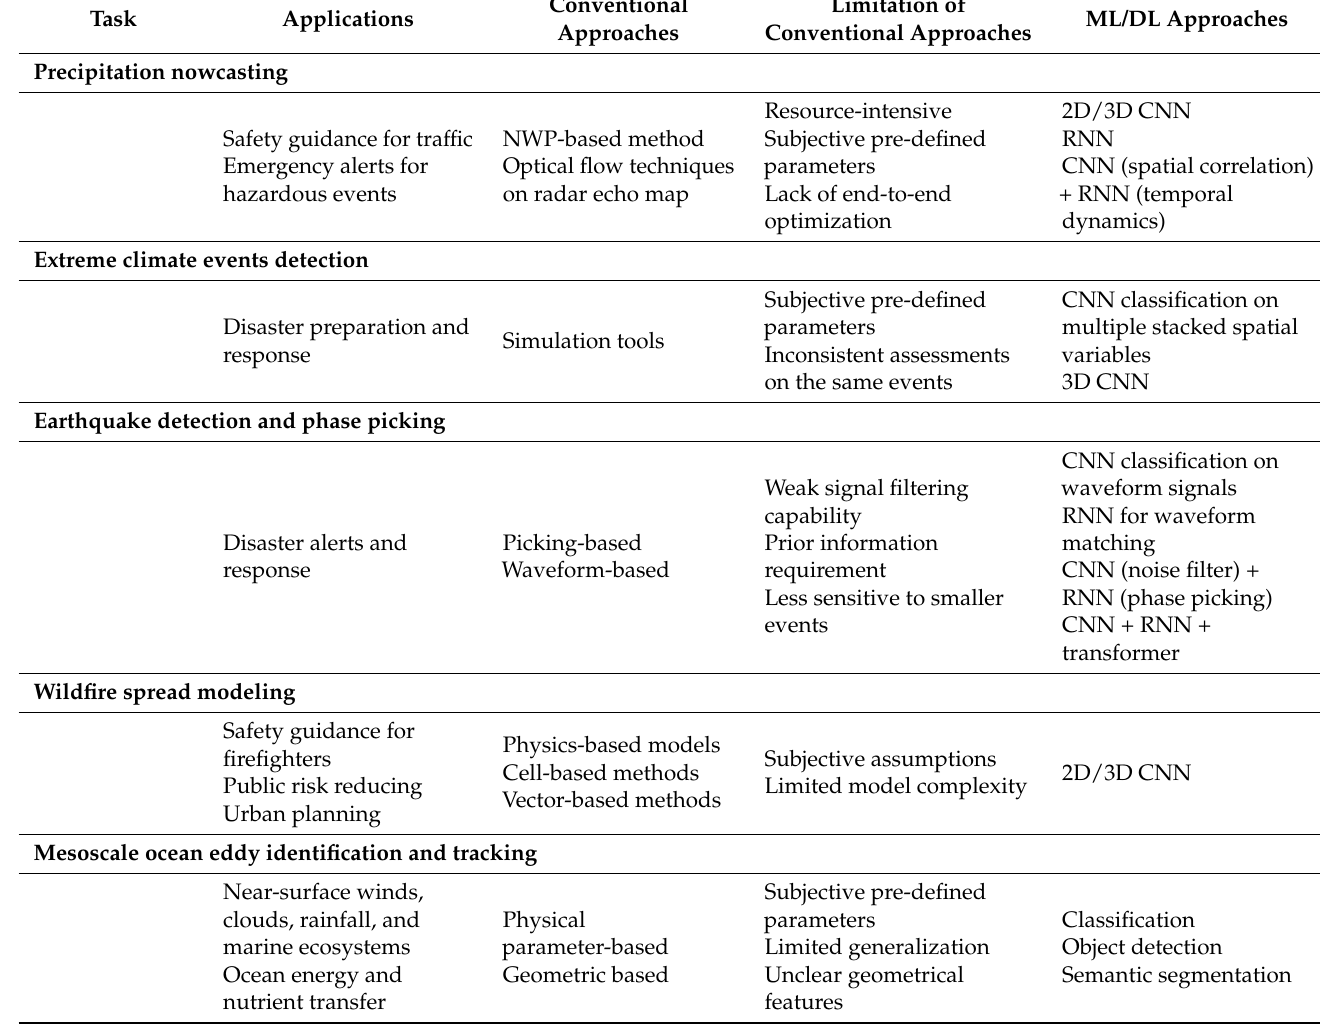
Table 3. Summary of GeoAI and deep learning applications in geoscientific data analysis, as well as limitations of conventional